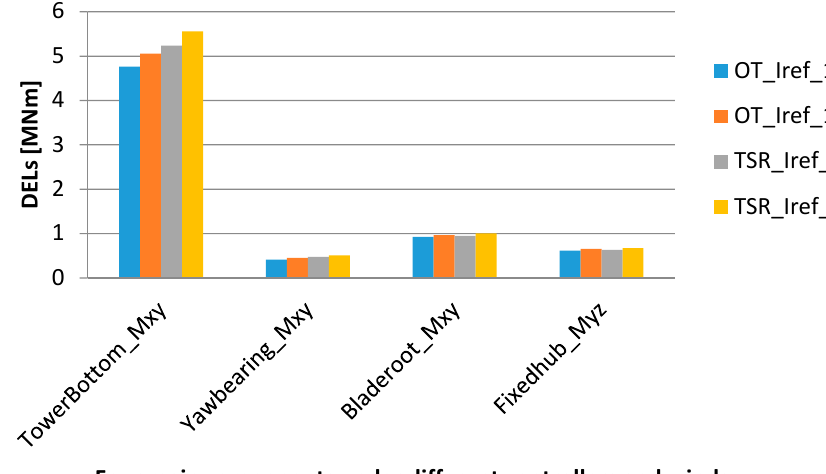
Figure 11. DELs of four main components under the two controllers with different TI.